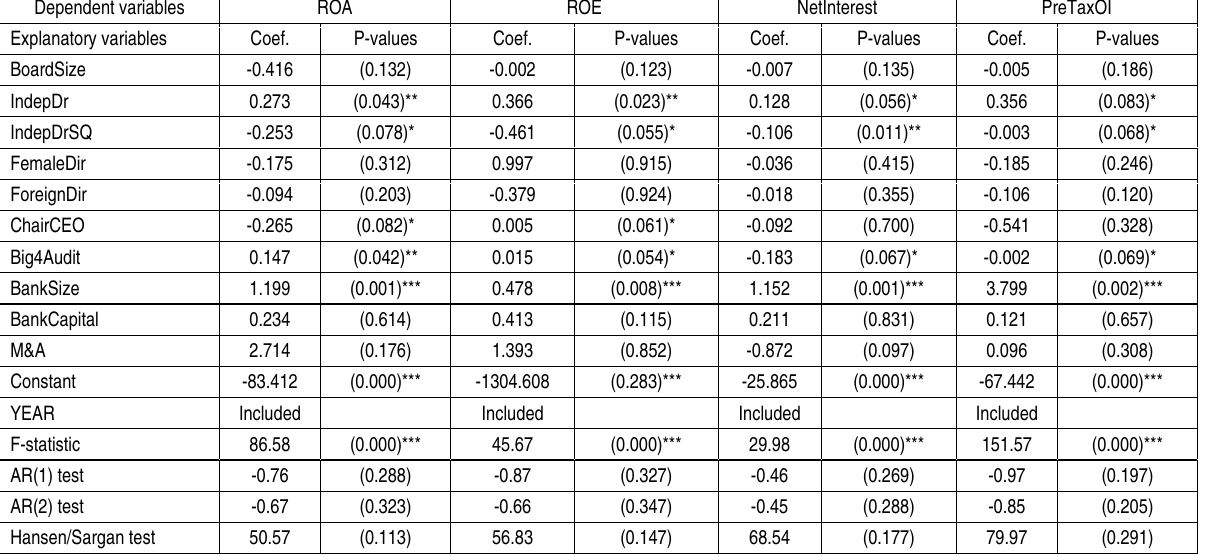
Table 5. Two-step system GMM empirical findings with the inclusion of